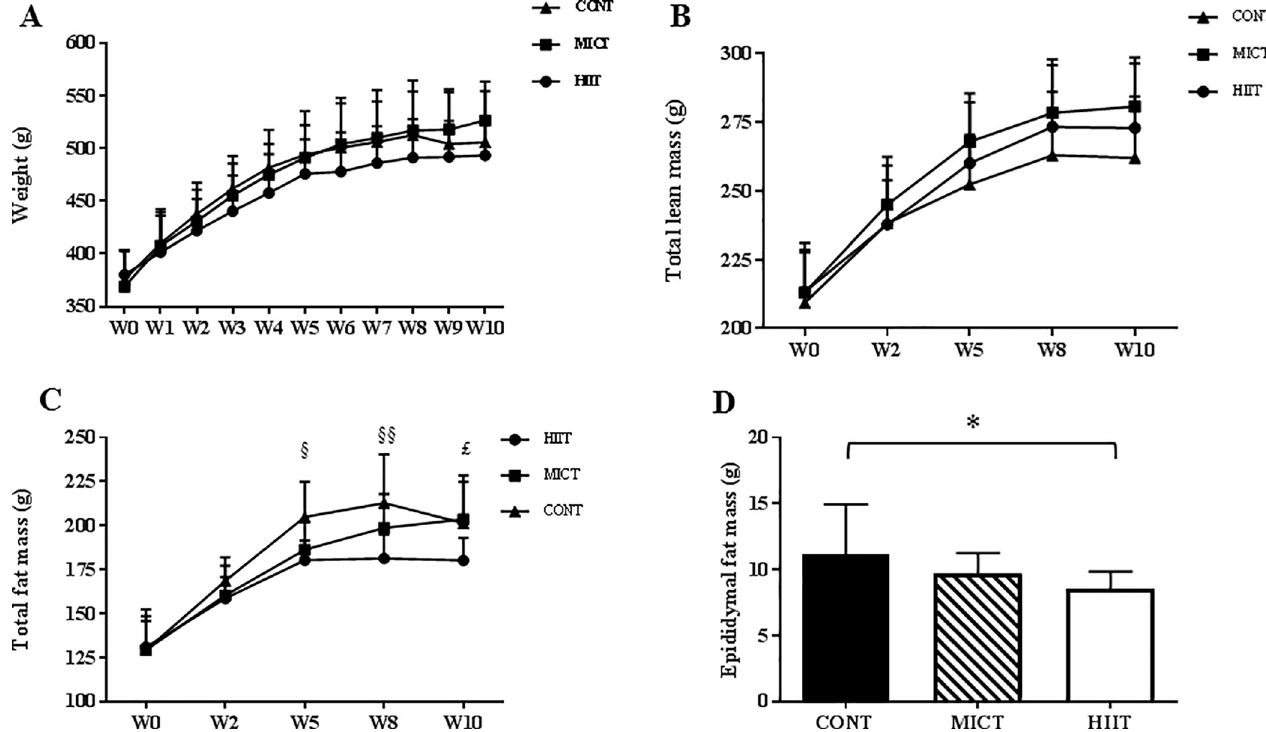
Fig 2. Effect of 10 weeks of exercise training on weight and body composition. Body weight (A), total lean mass (B), total fat mass (C) and epididymal fat mass (D). Data are expressed as the mean ± SD. § p � 0.05 CONT vs. HIIT; § § p � 0.01 CONT vs. HIIT £ p � 0.05 HIIT vs. MICT and � p � 0.05. https://doi.org/10.1371/journal.pone.0214660.g002 PLOS ONE | https://doi.org/10.1371/journal.pone.0214660 April 9,